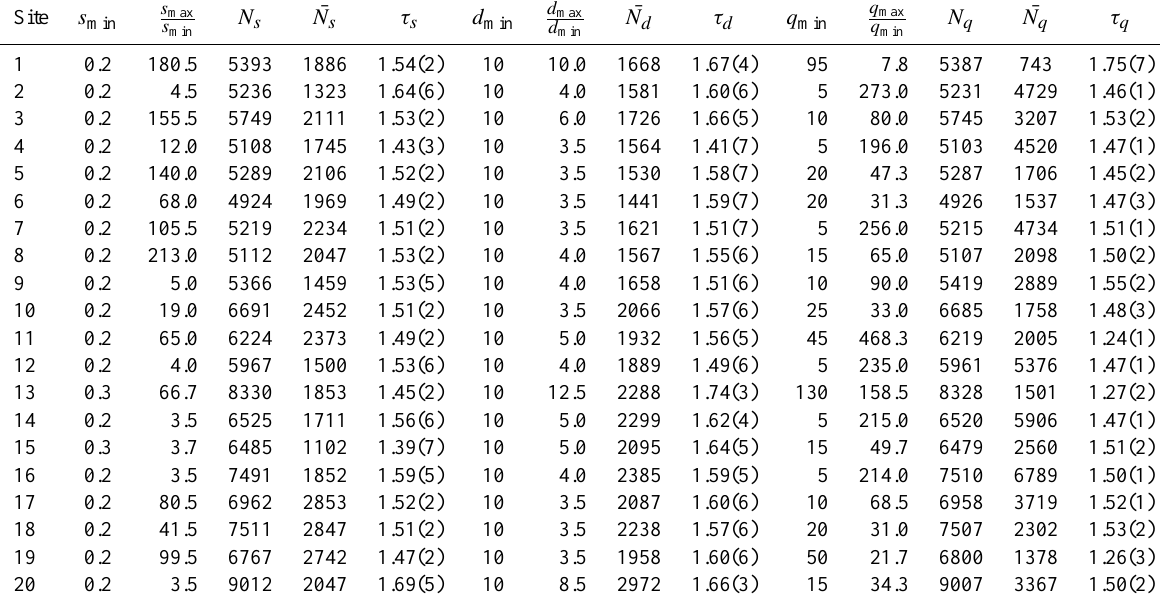
Table 2. Results of the power-law fitting and goodness-of-fit tests applied to event sizes, event durations, and dry-spell durations (in mm or in min), for the period of nine and a half years specified in the main text. The table displays the minimum of the fitting range, s min , and the ratio between the maximum and the minimum of the fitting range (logarithmic range, s max /s min ), total number of events, number of events in fitting range ( ¯ N s , ¯ N d , and ¯ N q , for s , d , and q , respectively), and the power-law exponent with its uncertainty (one standard deviation) calculated as stated by Bauke (2007) and displayed between parenthesis as the variation of the last